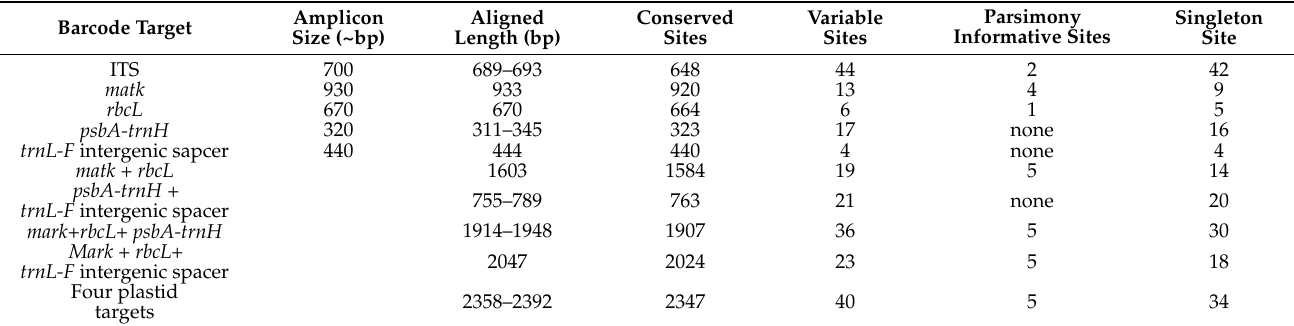
Table 3. Amplicon size of plastid loci and nuclear barcode regions in species of Tables 1 and 2 samples and sequence characteristics, namely single and different multi-locus